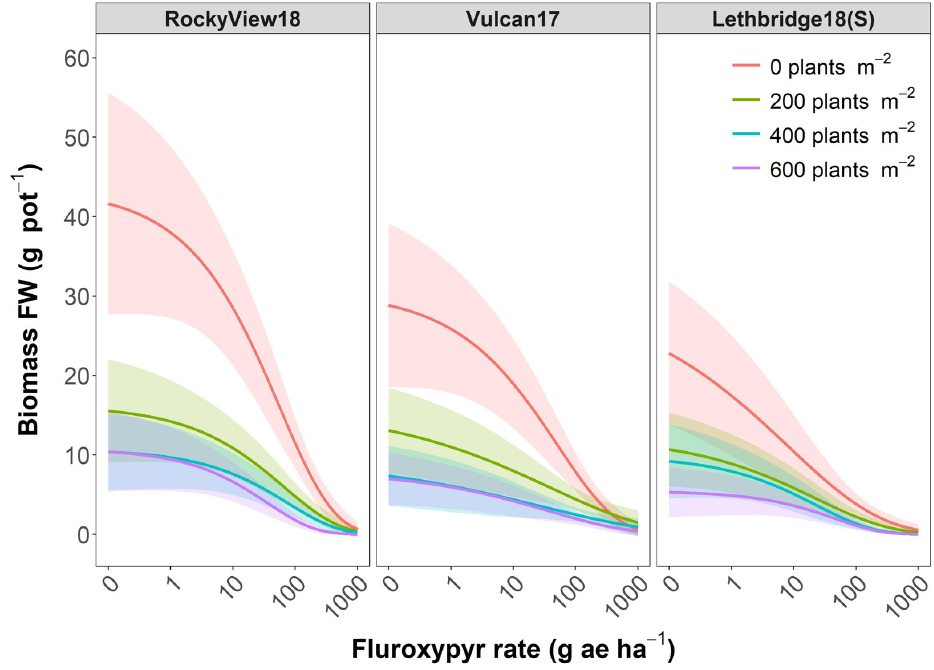
Figure 2. Shoot biomass fresh weight (FW) of the three kochia populations [RockyView18, Vul- can17, and Lethbridge18(S)] in response to fluroxypyr rate and wheat plant density (0, 200, 400, and 600 plants m − 2 ). Lines indicate predicted values from the fitted three-parameter Weibull type 1 model, while bands indicate the 95% confidence